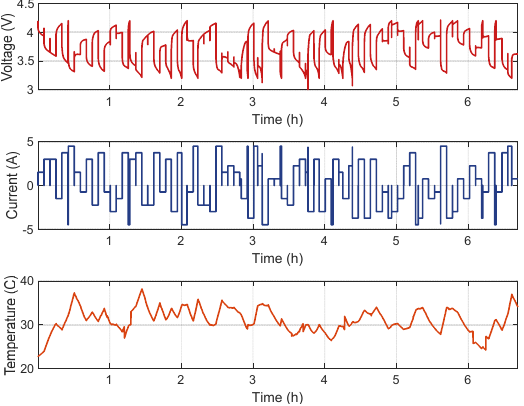
Figure 2. Voltage, current, and temperature of the first 100 steps measured for battery RW9.